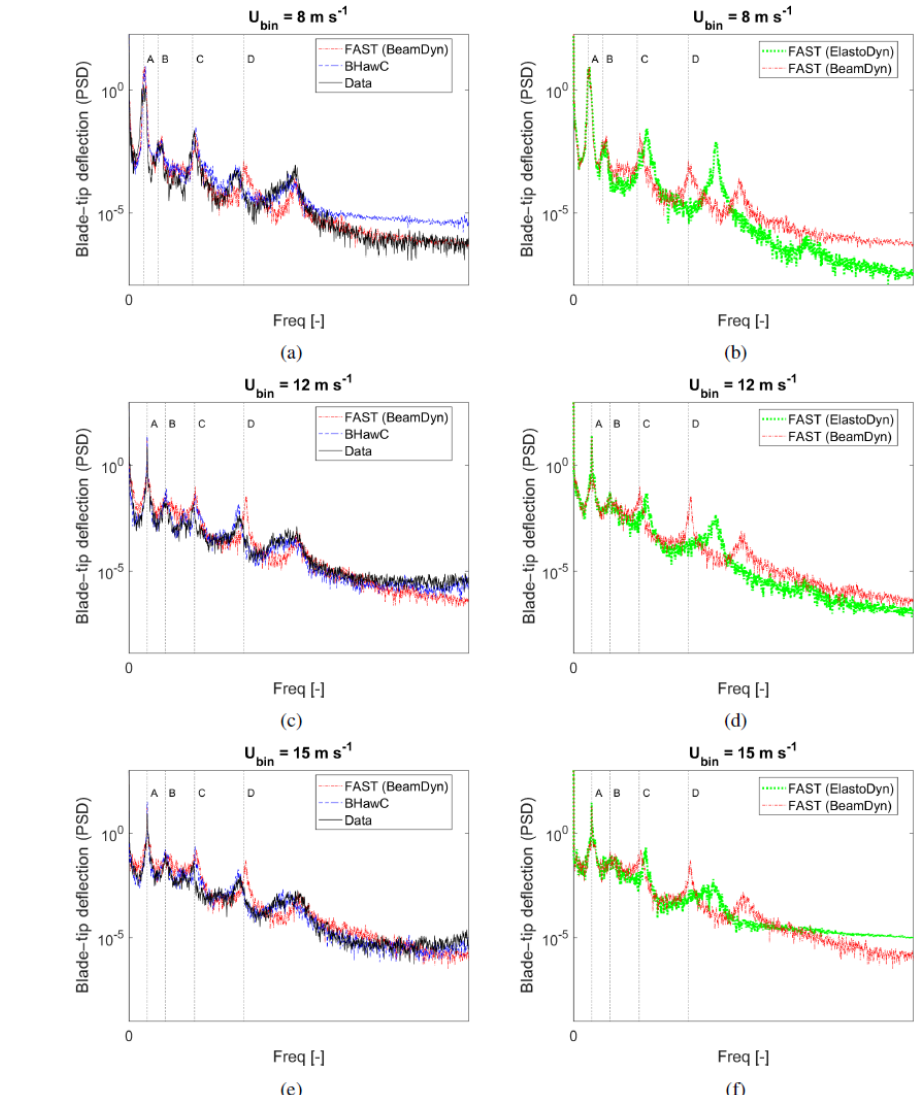
Figure 15. PSDs of the in-plane blade-tip deflection. The three sets of graphs represent the ensemble-averaged PSDs from the inflow velocity bins at 8ms − 1 (top), 12ms − 1 (center), and 15ms − 1 (bottom).